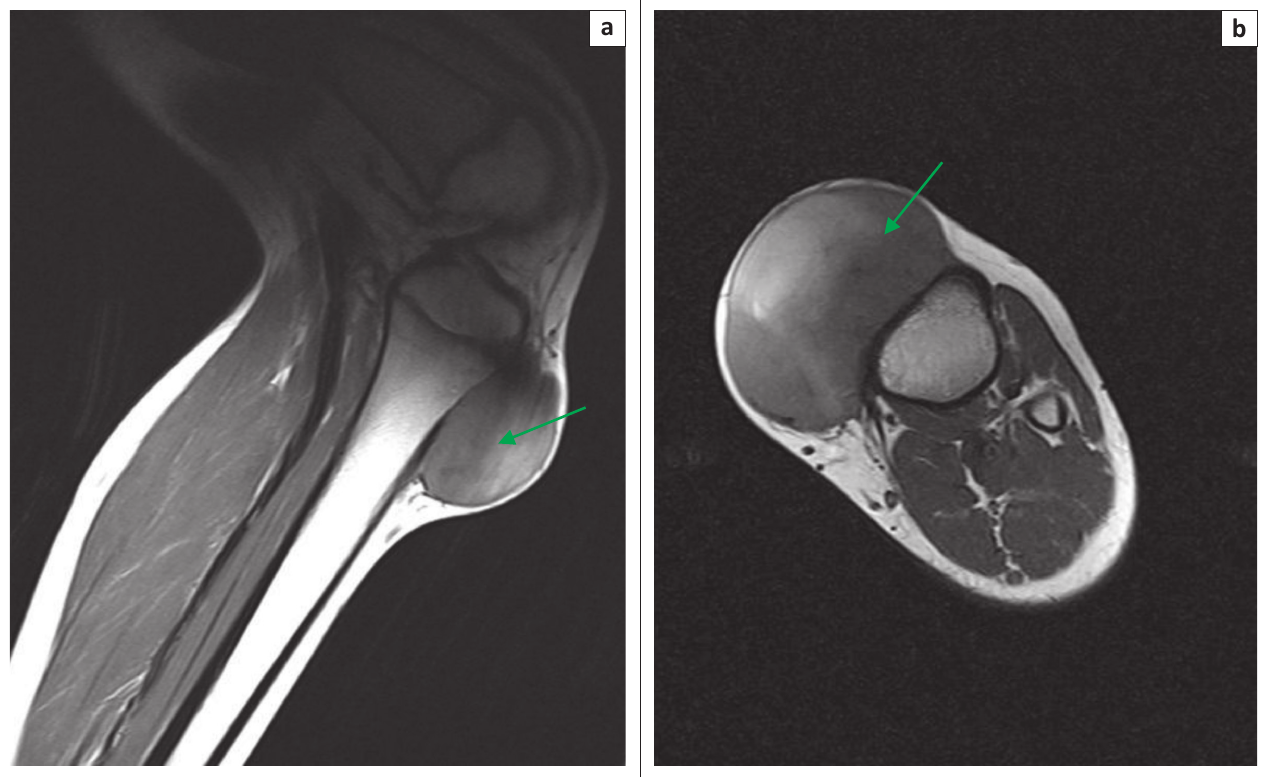
FIGURE 2: Sagittal (a) and axial (b) T1W images reveal mixed iso- and hyperintense changes within the soft-tissue mass (green arrows) owing to haemorrhage, without bony or subcutaneous fat